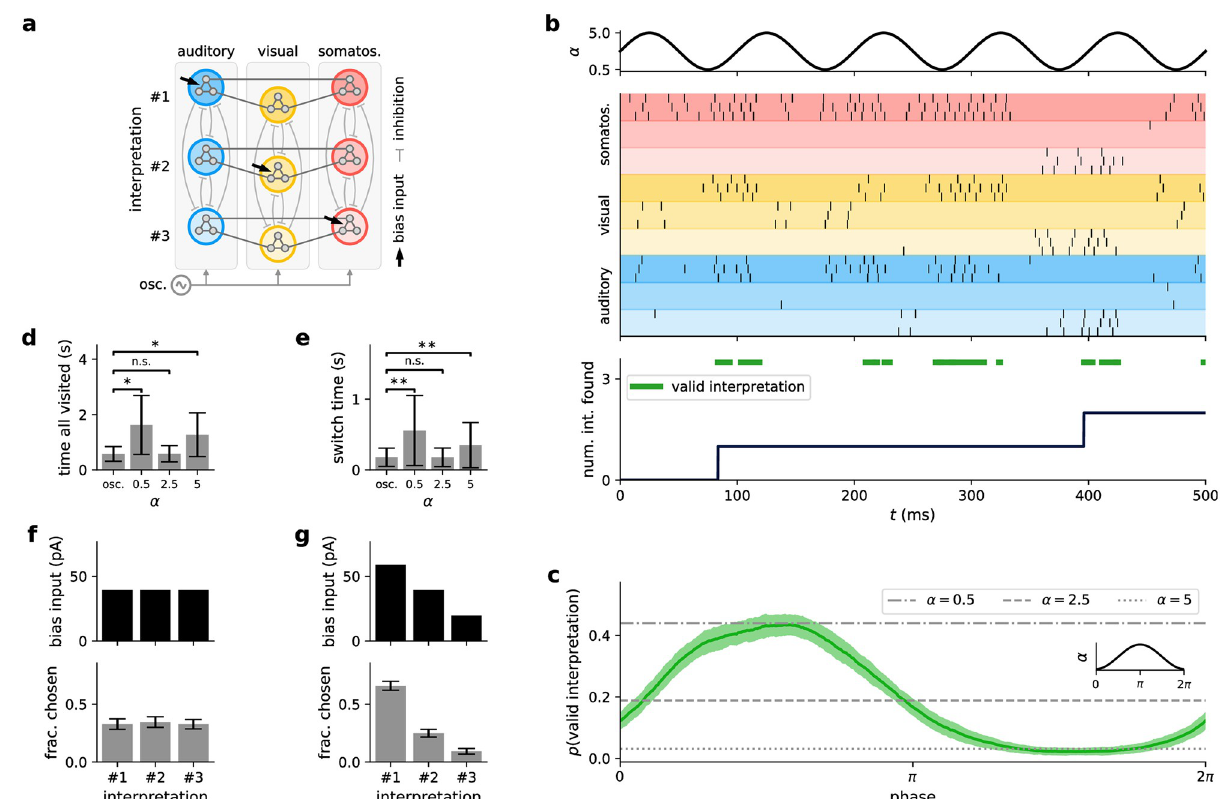
Fig 6. Background oscillations structure computations into sampling episodes in conductance-based networks. (a) Setup of stimulus disambiguation task. Assemblies (large colored circles) encode interpretation of stimulus spanning three different sensory modalities (auditory, visual, somatosensory). For each modality, every interpretation is encoded by the activity of a single assembly (different interpretations are represented by different color hues), with lateral inhibition ensuring that one interpretation is chosen. One assembly per sensory modality receives a bias input, resulting in ambiguous input. Simultaneous activity of connected assemblies encoding the same interpretation across all modalities encodes selection of an interpretation (i.e., a solution). All neurons receive oscillatory background input. (b) Network activity with oscillating background input. Top: background activity scaling by α . Middle: spike raster plot of network activity (color coding of assemblies as in panel a). Bottom: number of solutions (i.e., interpretations) visited so far. Green bars show times in which the network state encodes a solution. (c) Probability of network state encoding a solution depending on the phase of the oscillating background input. Gray lines show solution probabilities in networks without oscillating background activity for different activity levels α 2 {0.5, 2.5, 5}. Inset shows background activity phase for reference. (d) Mean time until the network has visited all three solutions for oscillating and constant background activity (over N = 100 runs for each case). Bars and whiskers show mean and standard deviation, respectively. Significance was calculated with Wilcoxon rank-sum test with � ^ ¼ p < 10 (cid:0) 10 and n : s : ^ ¼ p > 0 : 05 . (e) Time between choosing distinct solutions (see Section Methods for details). Plot as in panel d with �� ^ ¼ p < 10 (cid:0) 100 . (f) For constant bias inputs (top, cf. panel a), solutions are chosen equally often (bottom, means and standard deviations). (g) For different bias inputs (top), the probability of choosing the corresponding solution matches the input values (bottom). Plot as in panel